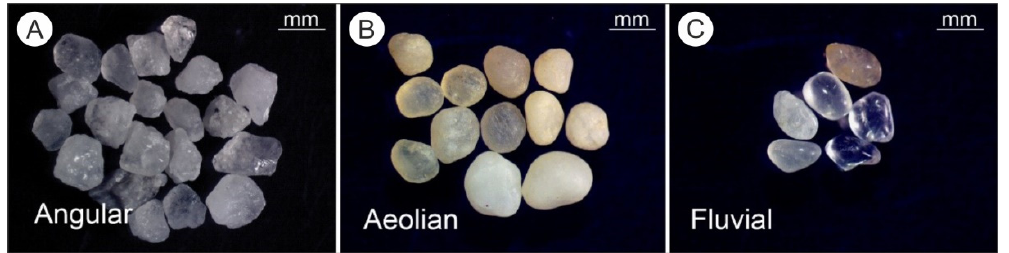
Figure 2. Examples of grains developed under different environmental conditions.